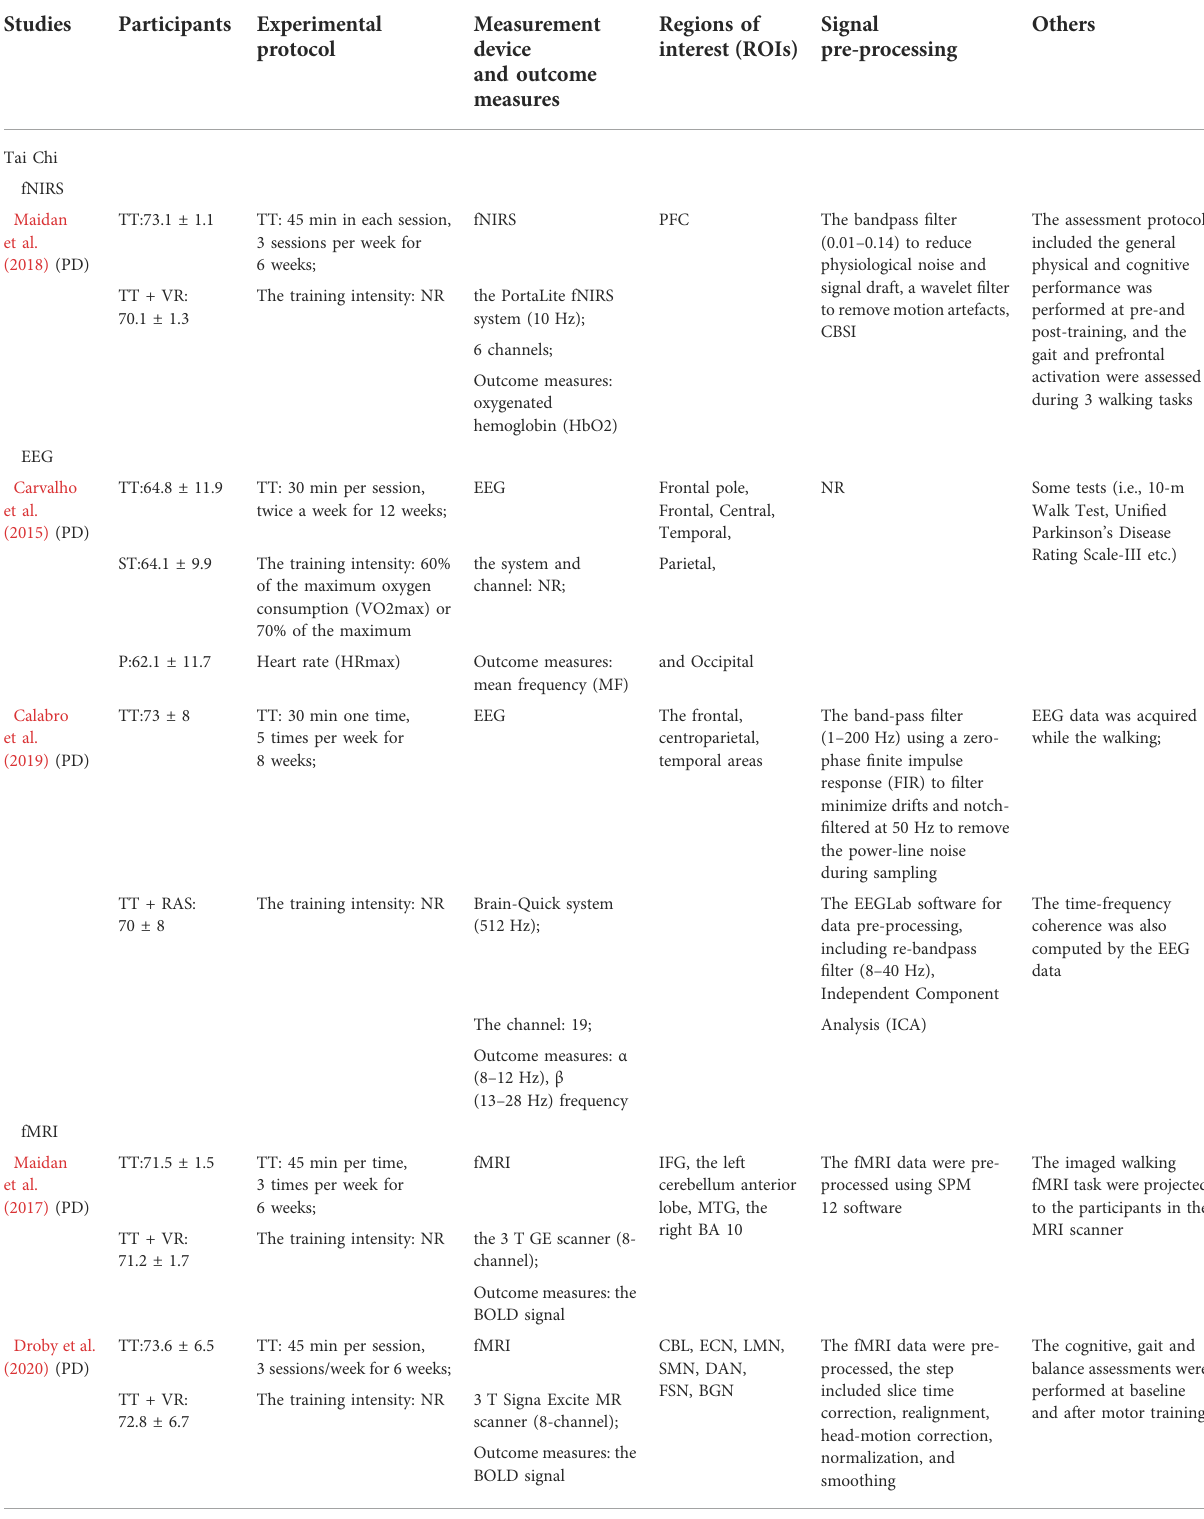
TABLE 3 Characteristics of the studies in people with